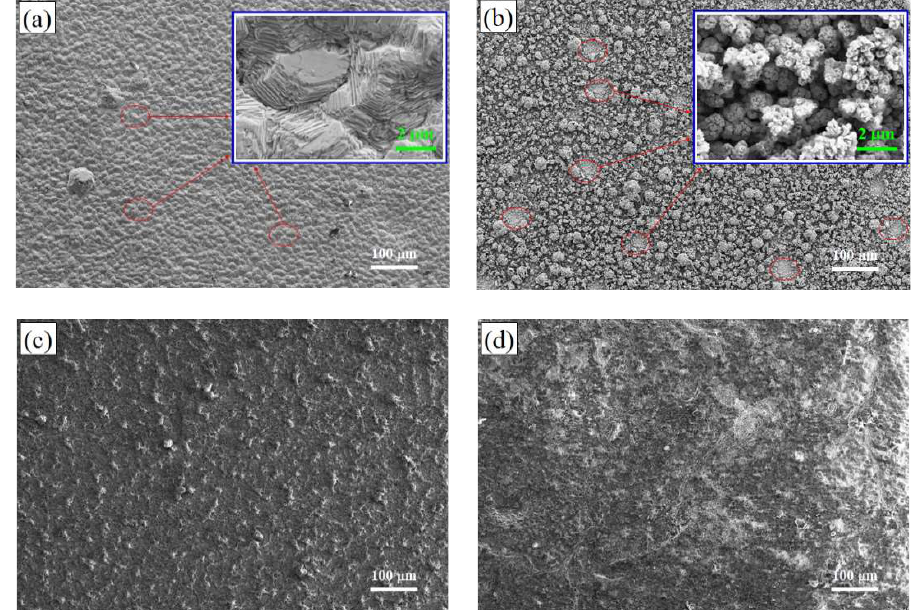
Figure 7. Scanning electron microscopy (SEM) images of ( a ) Zn; ( b ) SiC/Zn; ( c ) POT-SiC/Zn and ( d ) PMT-SiC/Zn coatings.